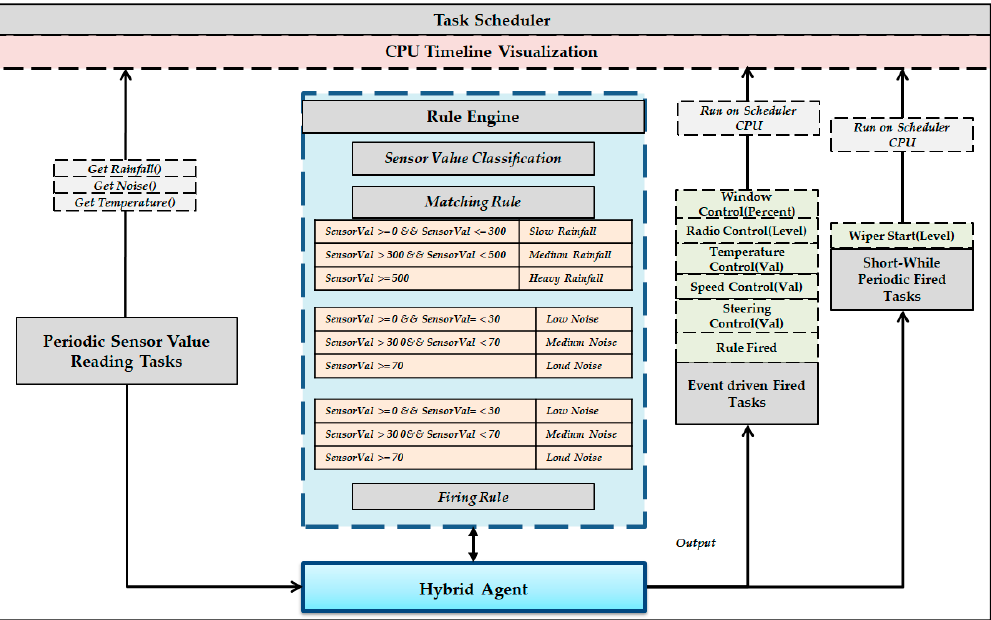
Figure 11. Simulation execution of the task scheduling and inference module for the example scenario.